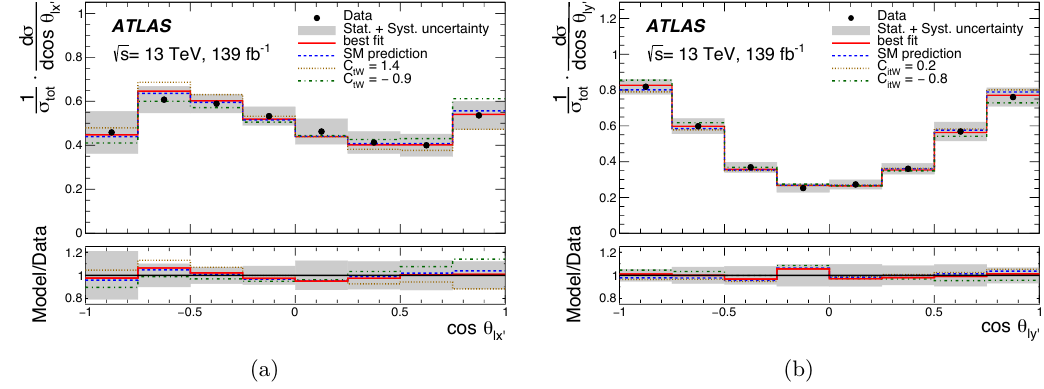
Figure 10 . Comparison of data and the result of the EFT fit for the polarisation angles (a) cos θ and (b) cos θ . The solid points show the data, unfolded to particle level. The solid ‘x 0 ‘y 0 red line corresponds to the EFT prediction using the best-fit values for the Wilson coefficients C tW = 0.3 and C itW = − 0 . 3 . The blue dashed line represents the SM prediction obtained with the MadGraph5_aMC@NLO+Pythia 8 generator. The brown dotted (green dash-dotted) line shows the model at its upper (lower) 95% CL bounds for (a) C (b) C = 0 . 2 ( C = − 0 . 8 ) also obtained with the MadGraph5_aMC@NLO+Pythia 8 itW itW generator. The uncertainty bands include both the statistical and systematic uncertainties. The lower panel gives the ratio of the model to the data.